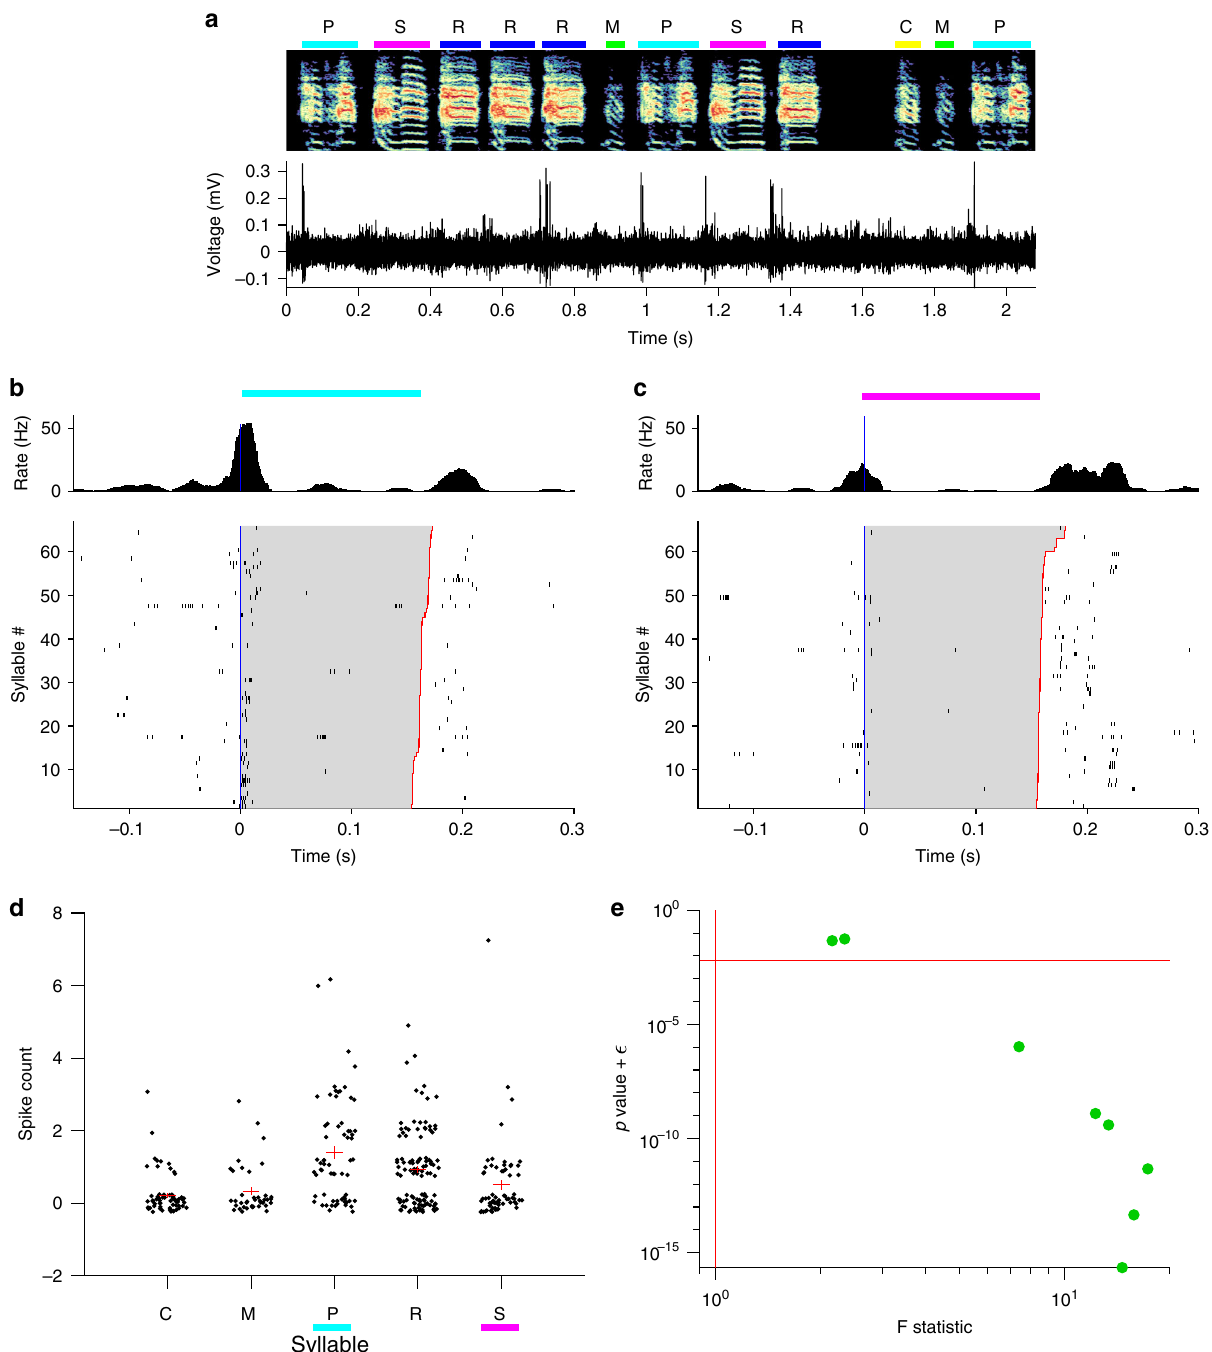
Fig. 6 Syllable selectivity of NIf HVC neurons during tutoring. a Example of a NIf neuron recorded as a juvenile listened to different tutor syllable types, each marked by a different color. b Onset-aligned raster and PSTH for syllable P. c Onset-aligned raster and PSTH for syllable S. Note that this neuron fi res more before syllable P than syllable S (two-sample t -test p < 9.5e − 05). d Scatter plots showing spike counts of this neuron across different syllable types ( n = 351 syllables). Spike counts were calculated in a window from 50 ms before syllable onset to 20 ms after syllable onset. Datapoints are jittered for ease of view. A one-way ANOVA was run to assess whether different syllable types had signi fi cantly different mean spike counts ( F = 8.5; p = 1.5 × 10 − 6 ). Horizontal red lines indicate the mean spike count for each syllable type, and vertical red lines indicate the standard error of the mean. e Scatter plot showing one-way ANOVA p -values and F -statistics for all signi fi cantly onset-locked NIf HVC neurons recorded while birds listened to their tutor song. Horizontal red line shows Bonferroni-corrected signi fi cance threshold for p = 0.05. Vertical red line indicates F -statistic of